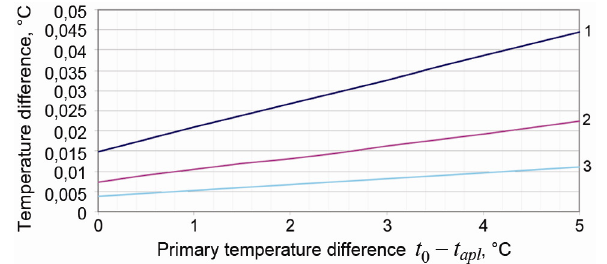
Fig. 3. The dependence of plant leaf temperature change ∆ t on the initial difference in temperatures between the plant leaf and the surrounding environment when the plant leaf is oscillating with respect to the radiation source at amplitude β A = 30°. Plant leaf thickness is 0.2 mm. Plant leaf oscillation